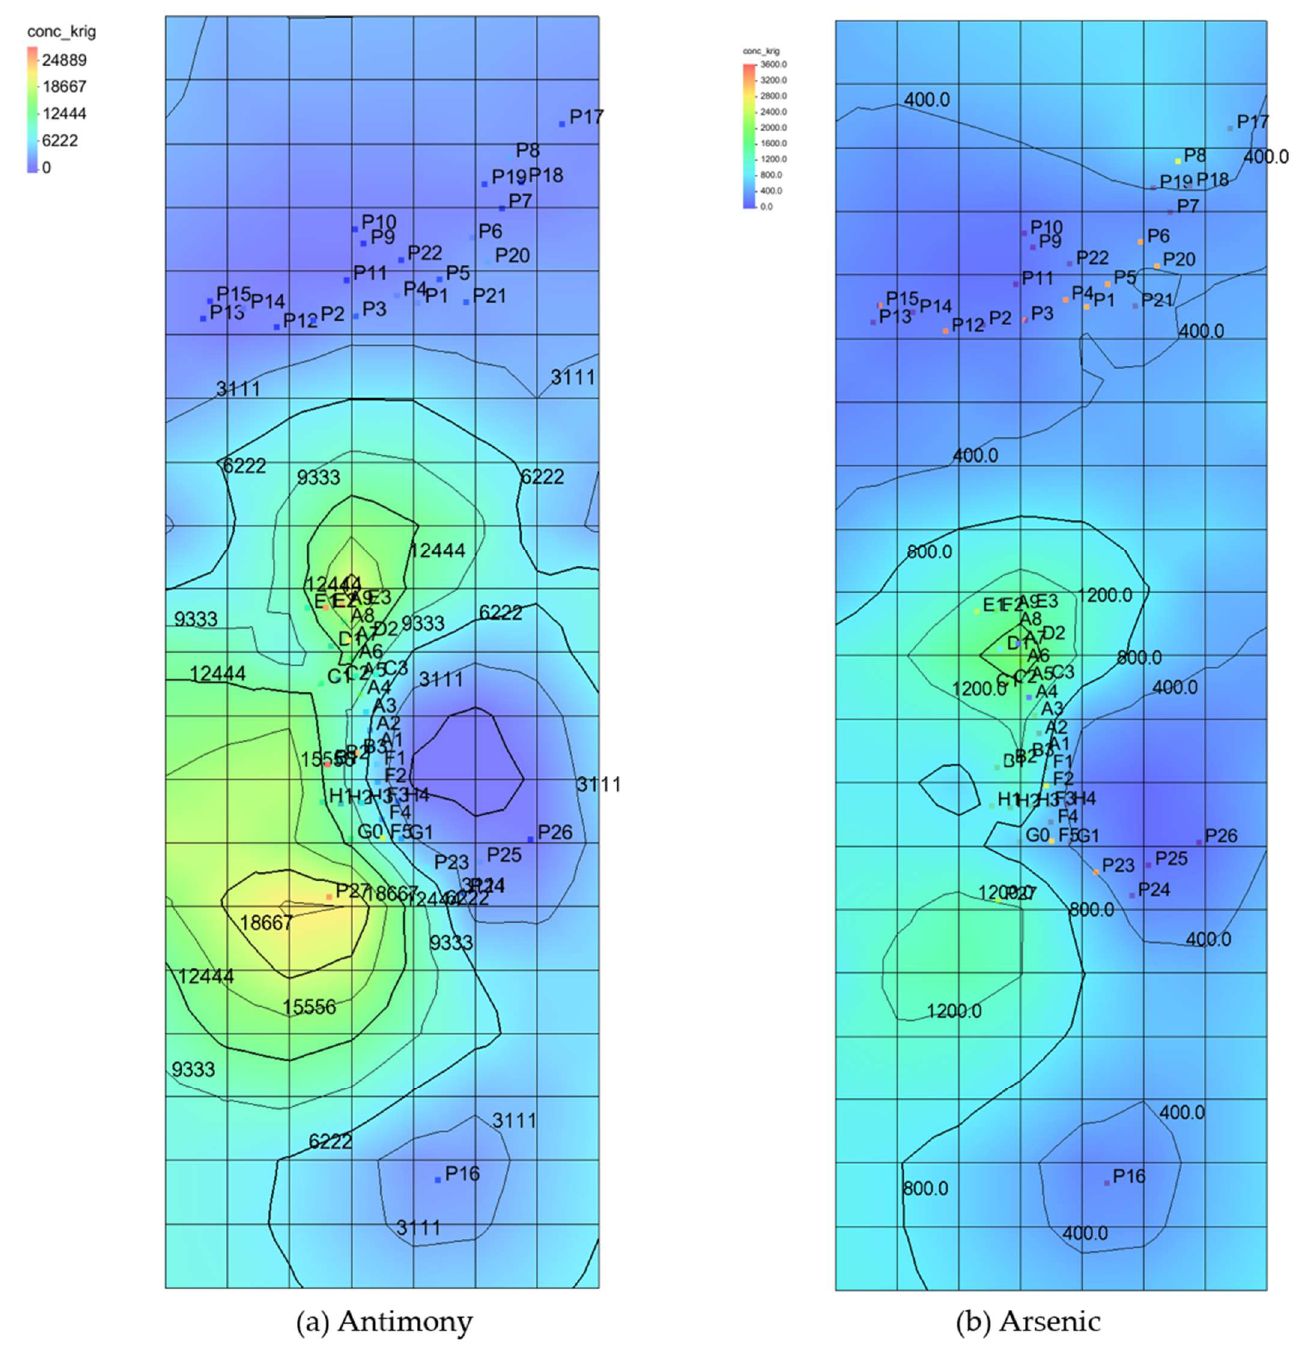
Figure 7. Space distributions of antimony and arsenic (ppm) by ordinary kriging.